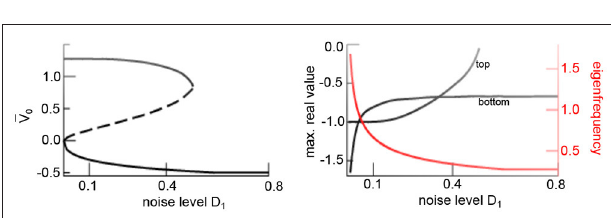
FIGURE 5 | Additive noise induces bistability. Equilibria of (17) as a function to the noise level D 1 showing noise-induced hysteresis. (Left) Asymptotically stable (solid) and unstable states (dashed). (Right) Maximum real eigenvalues of stable states (black) and eigenfrequency of bottom equilibrium (red). Other parameters are taken from Figure 4 . Results for W n ( t ) are